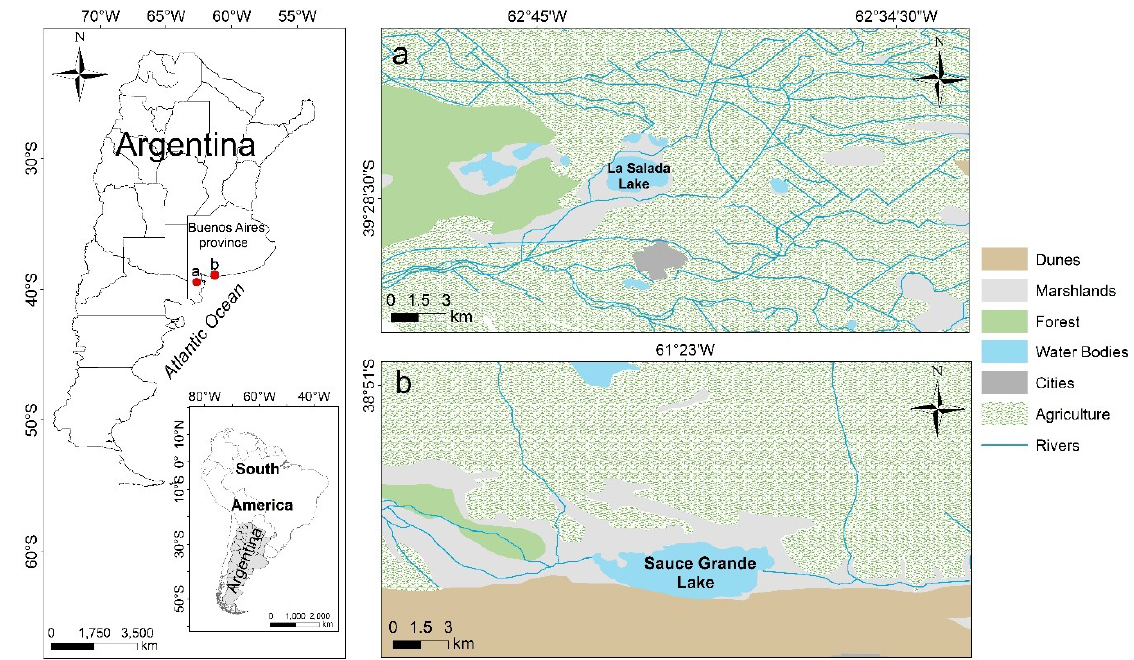
Figure 1. Geographic location of the study sites with respect to their surroundings: ( a ) La Salada lake location and land use; ( b) Sauce Grande lake location and land use.